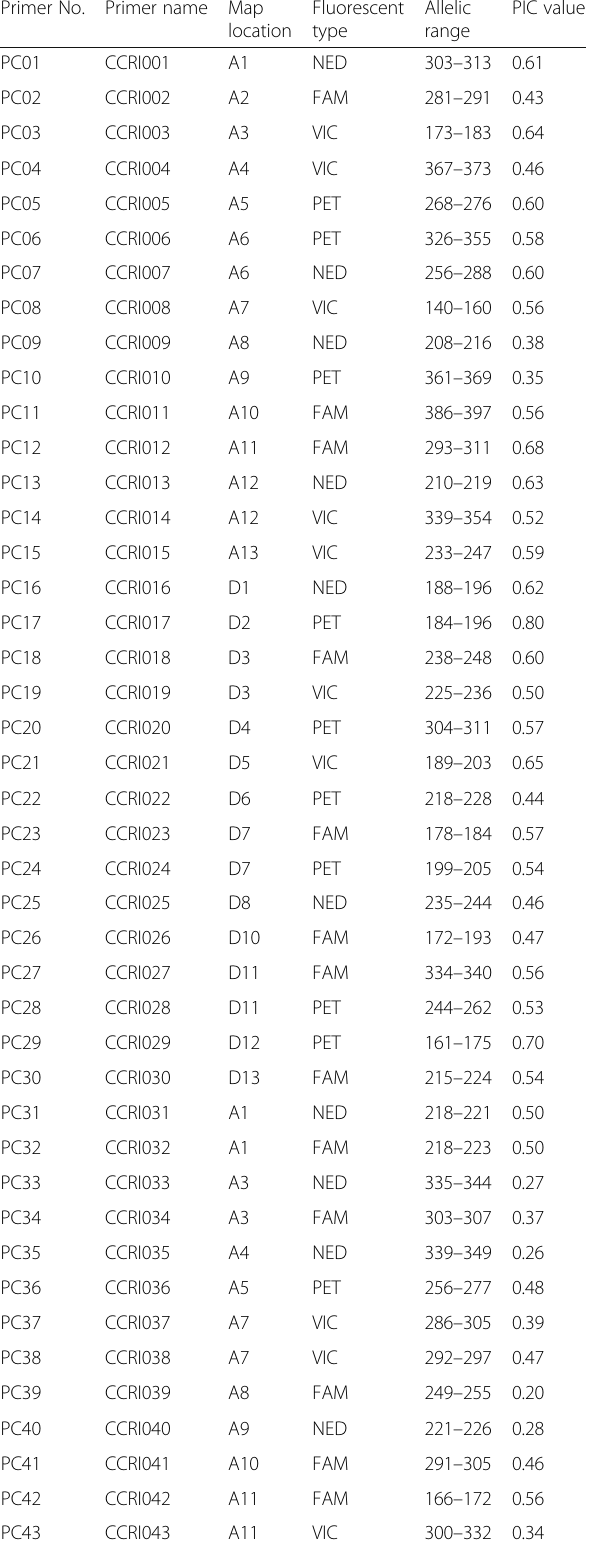
Table 2 Information on 60 perfect SSR primers Primer No. Primer name Map Fluorescent location type